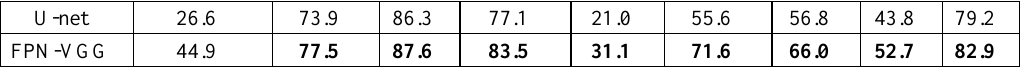
Table 1. Performance of different networks with input data of RGB images. The metric for individual class is F1 (%). Spectral Background LowVeg bands